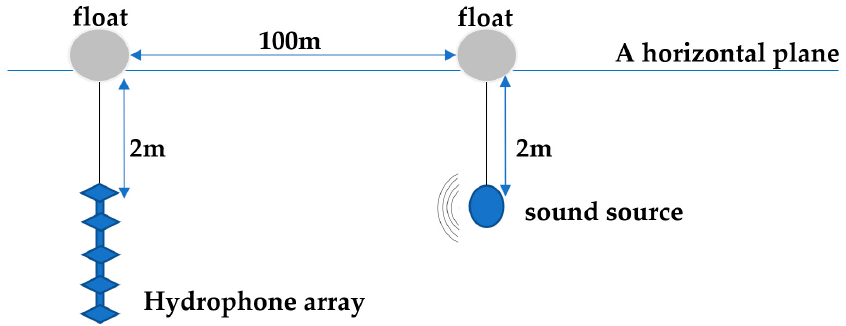
Figure 11. The procedure of collecting the underwater acoustic signal.